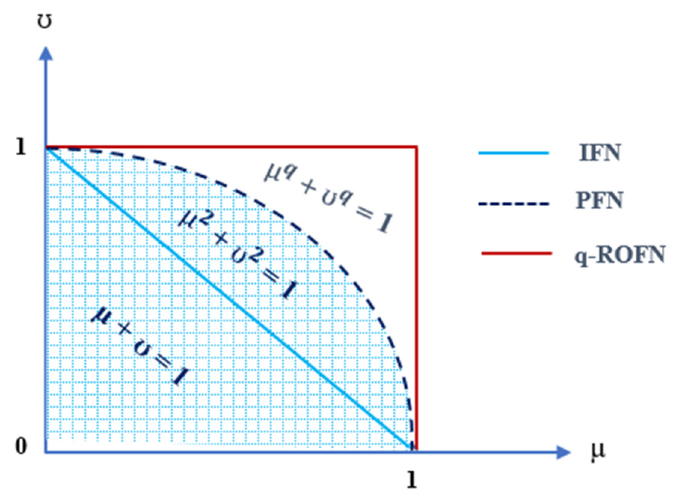
Figure 2. Comparison of the geometric area of various fuzzy membership degrees: IFNs, PFNs, and q-ROFNs.